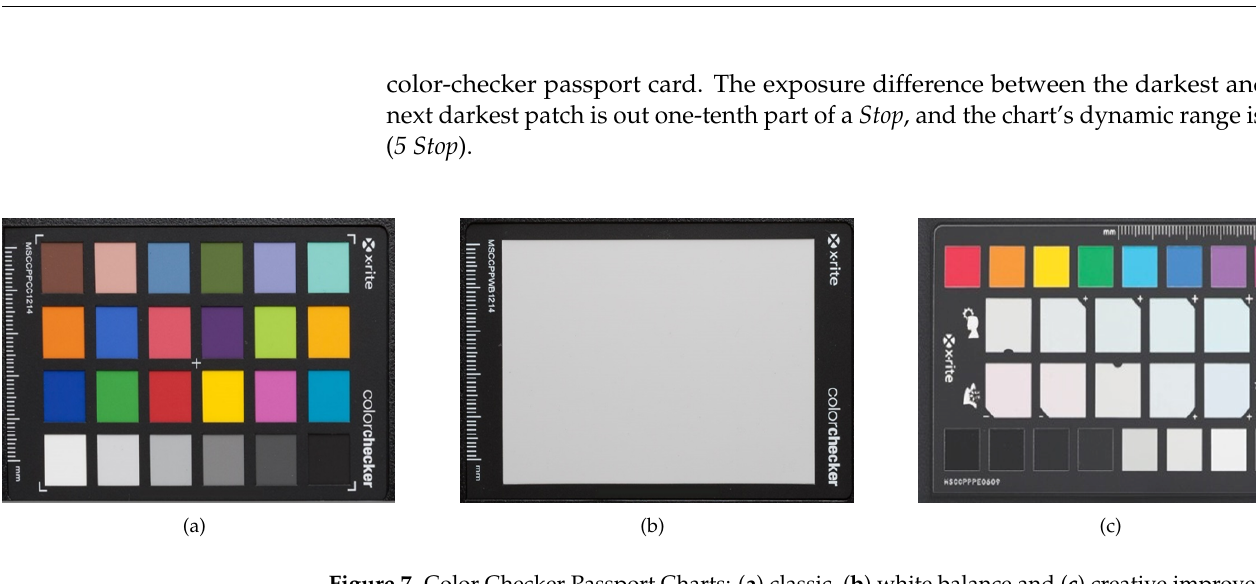
Figure 7. Color Checker Passport Charts: ( a ) classic, ( b ) white balance and ( c ) creative